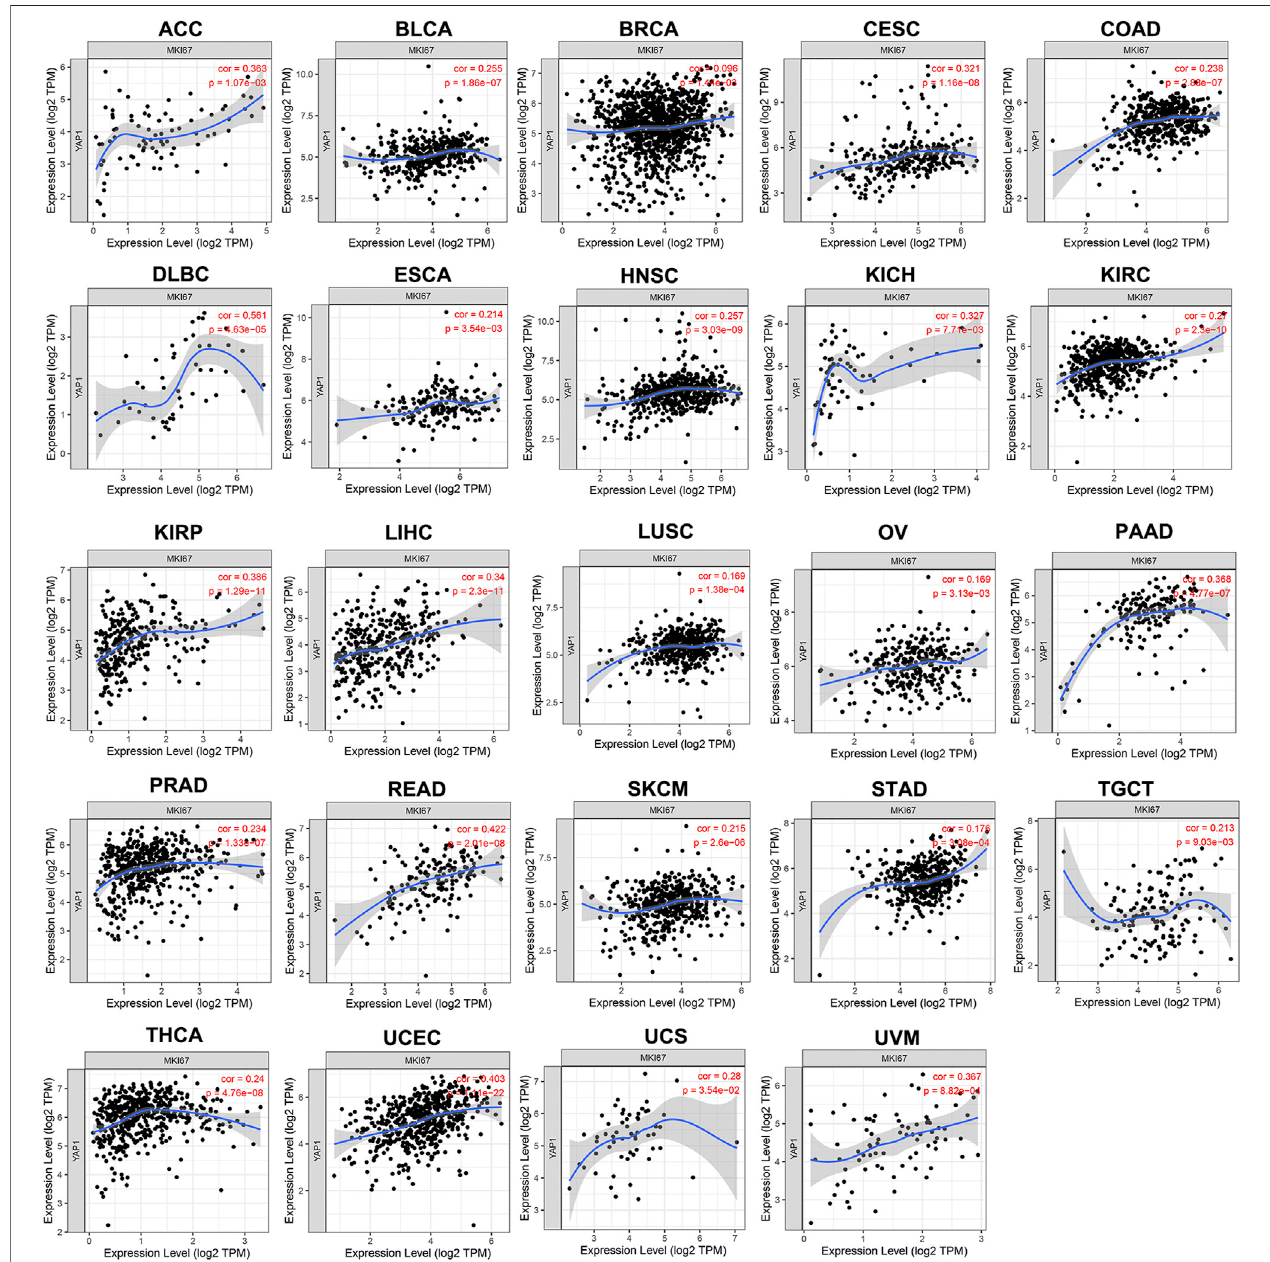
FIGURE 4 | The positive correlation between YAP1 and MKI67 expression analyzed by TIMER in pan-cancer.